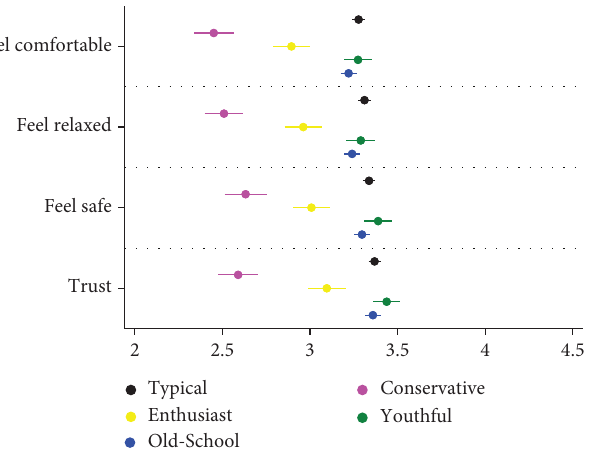
Figure 8: Mean values of attitudinal variables with 95% confdence interval by consumer classes. Measured items on the vertical axis: I would feel comfortable giving control to a CAC; I would feel re- laxed giving control to a CAC; I would feel safe using a CAC; I would trust a CAC for my everyday travel.